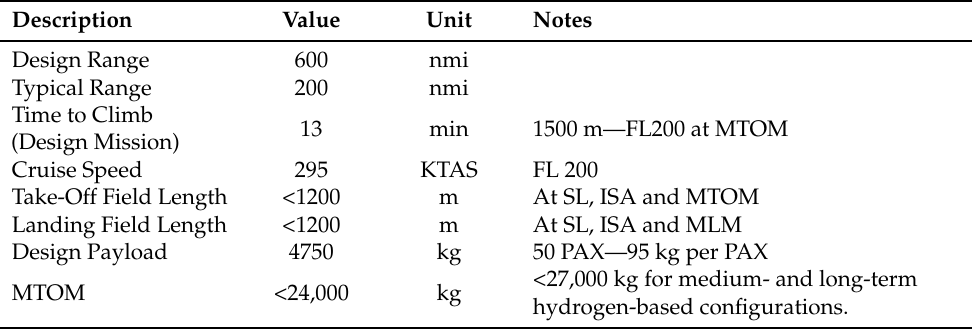
Table 1. Complete set of TLARs for the aircraft